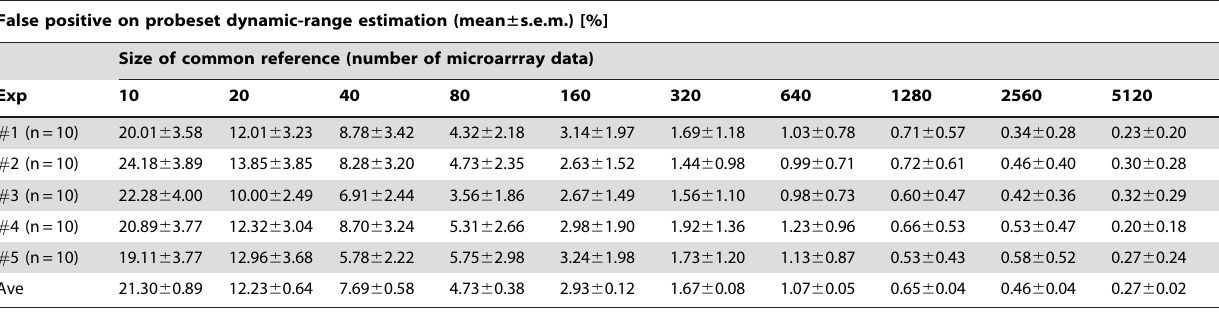
Table 2. Size of universal reference and probeset dynamic-range estimation Affymetrix Human U133 Plus 2 (54677 probesets).